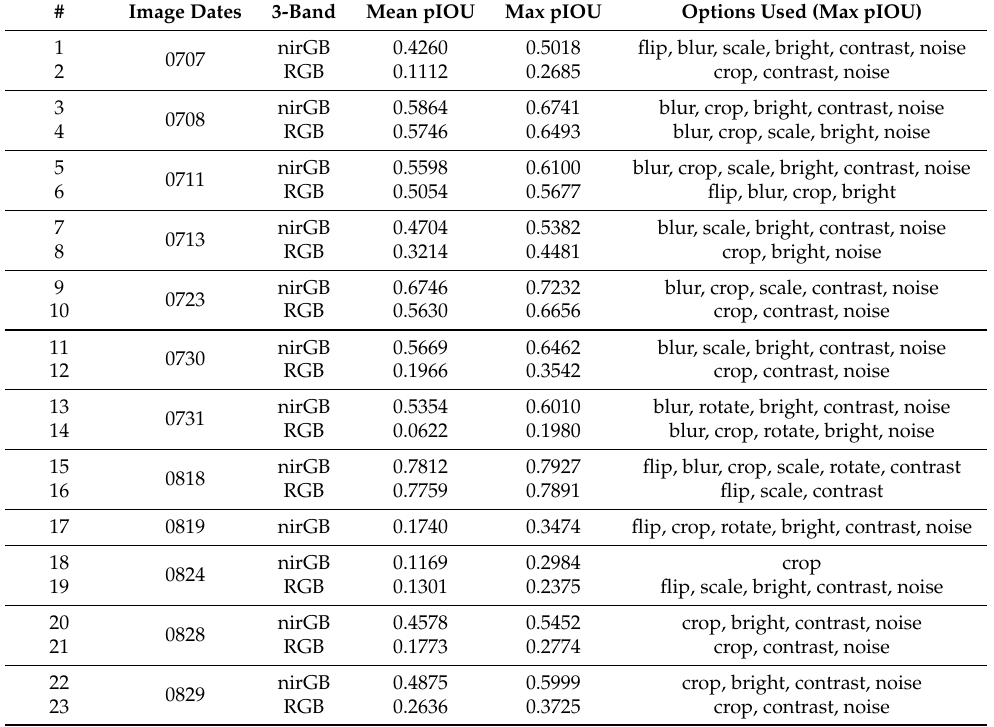
Table 4. Accuracy of deep learning models based on different test datasets. The table shows the mean and max pIOU of each test dataset when using the 255 models trained with different data augmentation options. The last column shows what data augmentation options were used in the model that achieved the maximum pIOU. Image acquisition dates are in the format of month day (e.g., 0708 means July 8).